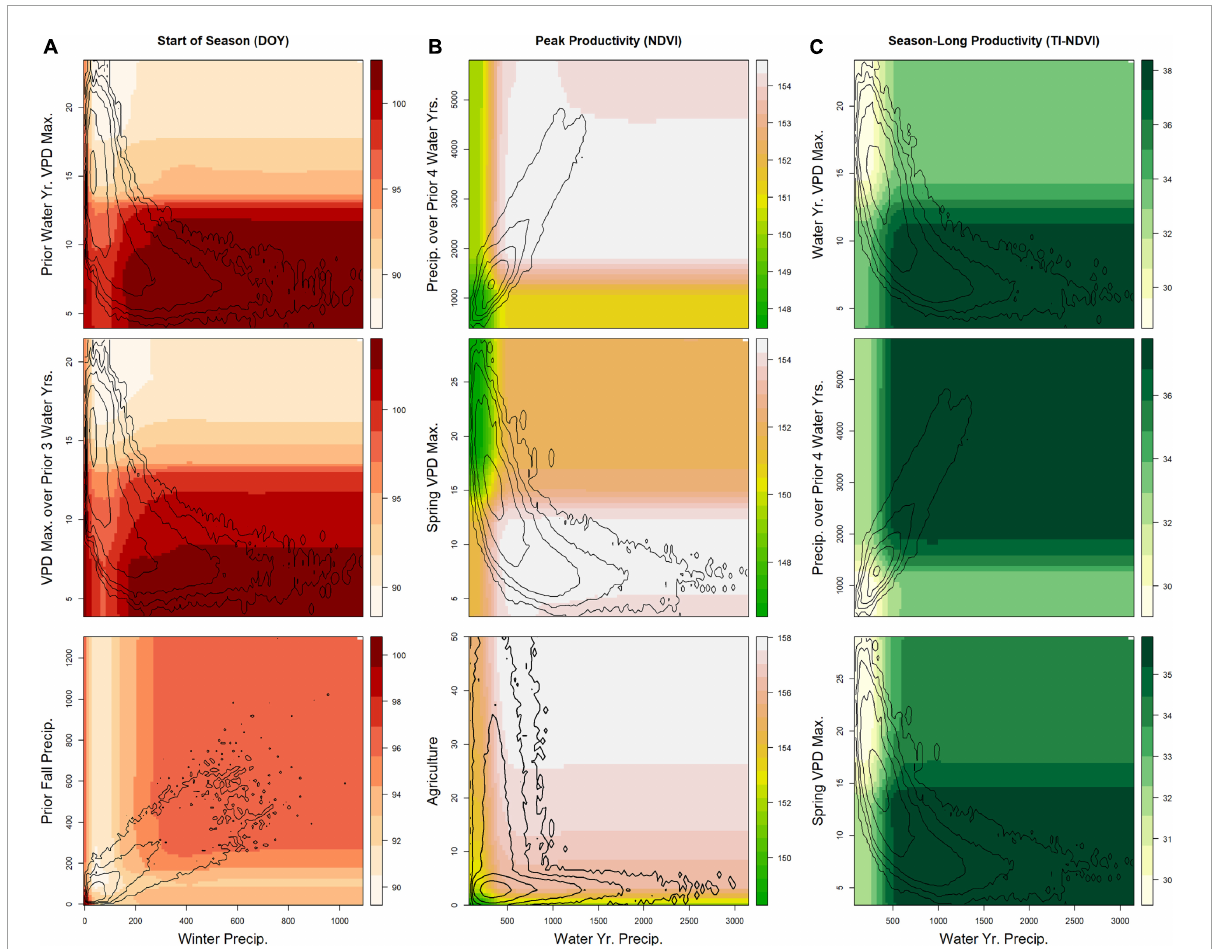
FIGURE4 Results from the final random forest models for areas of the U.S. Northwestern Plains having primarily shrub land cover pixels. For each phenological measure, three partial-dependence plots show the relationship between selected pairs of variables. Contour lines show the natural logarithm of the kernel density (i.e., the distribution of the two variables in the dataset). Seasonal and yearly variables represent either (A) the mean over the time period for temperature ( ◦ C, Temp.) and vapor pressure deficit (hPa, VPD), (B) the cumulative sum for precipitation (mm, Precip.), or (C) exceedance of vapor pressure deficit (days over 1 or 2 times the SD of the long-term distribution) and growing degree-days ( ◦ C, GDD). Max, Maximum; SD, standard